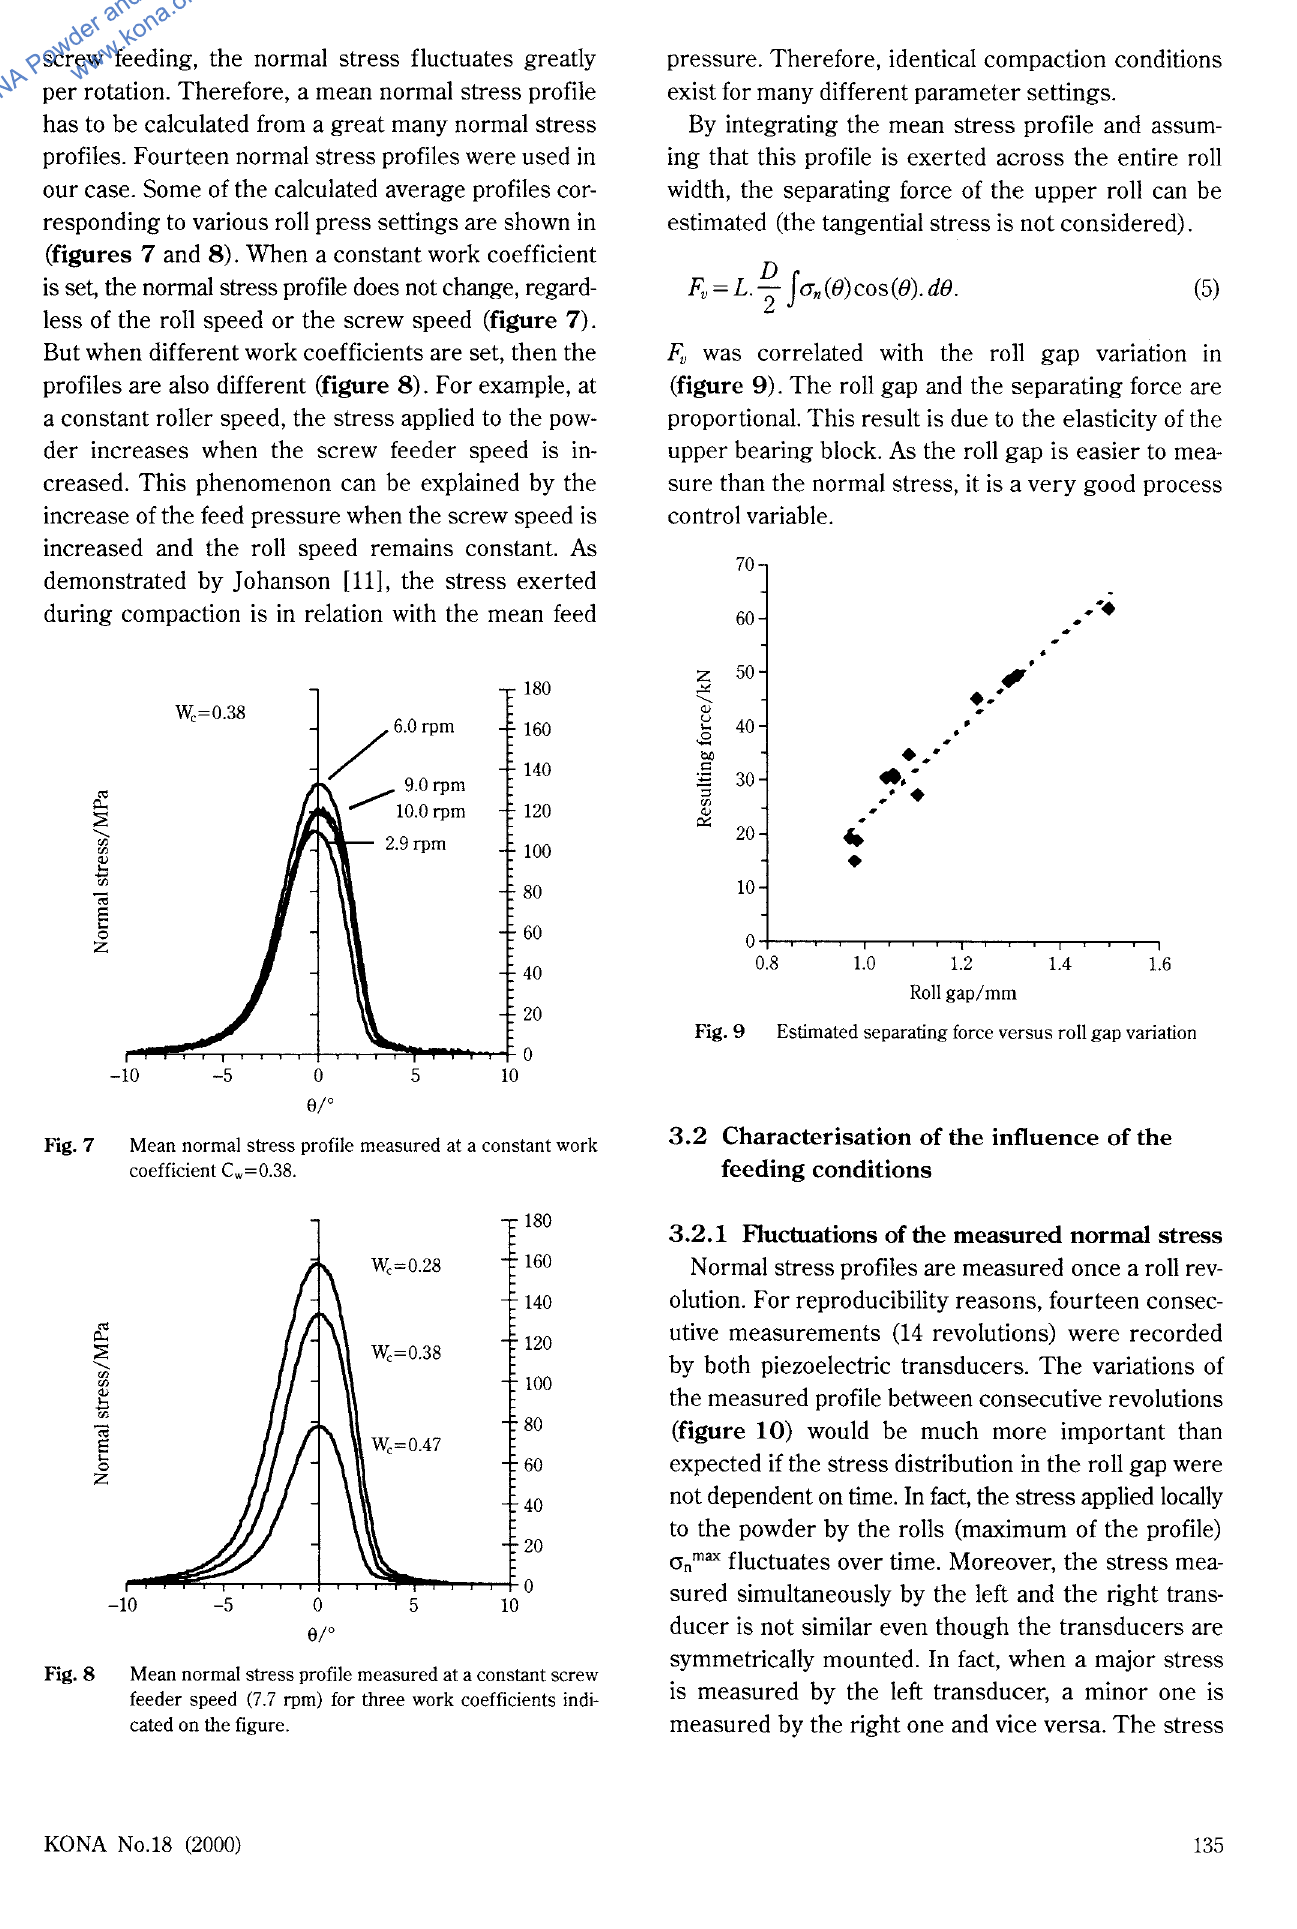
Fig. 8 Mean normal stress profile measured at a constant screw feeder speed (7. 7 rpm) for three work coefficients indi cated on the figure.